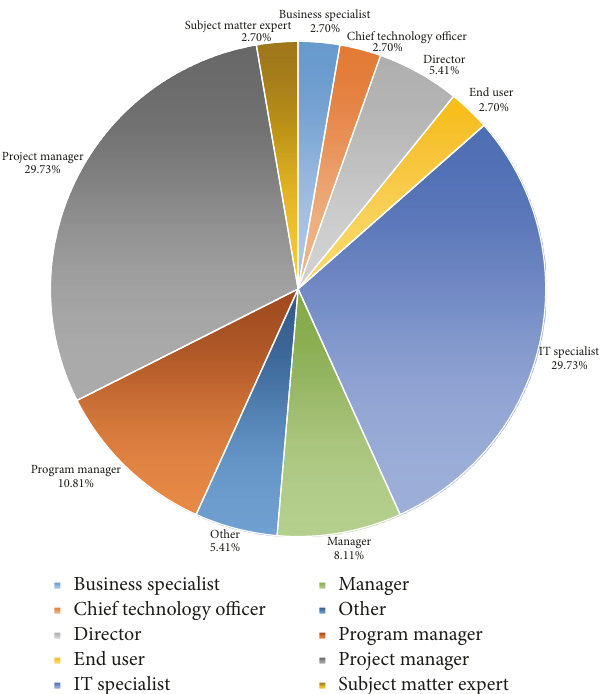
Figure 3: Professional profile of the respondents (%).